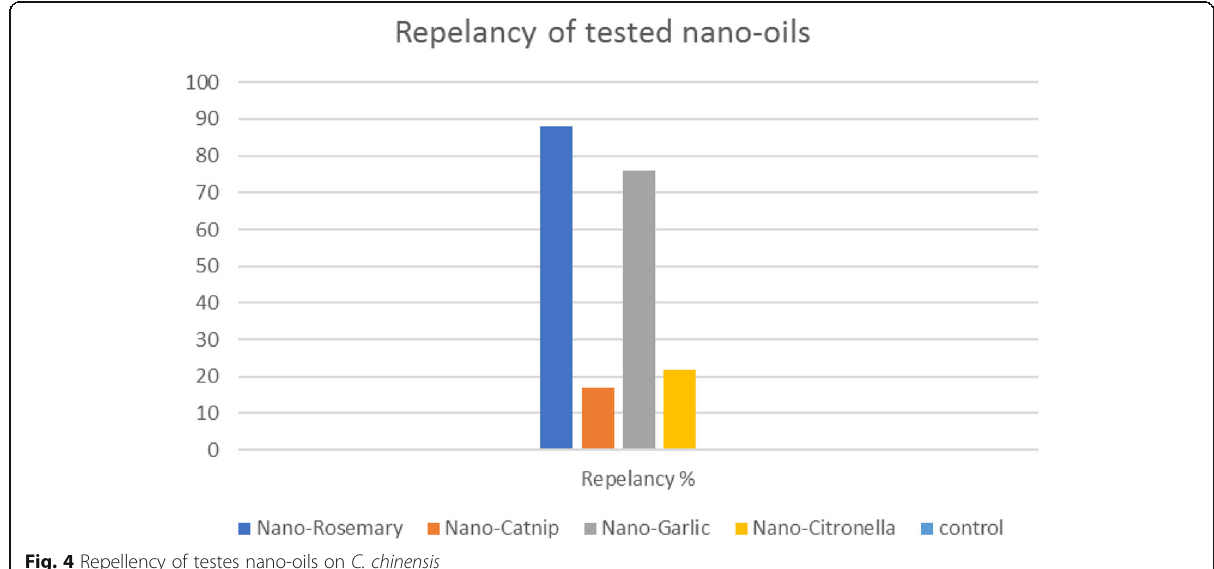
Fig. 4 Repellency of testes nano-oils on C.